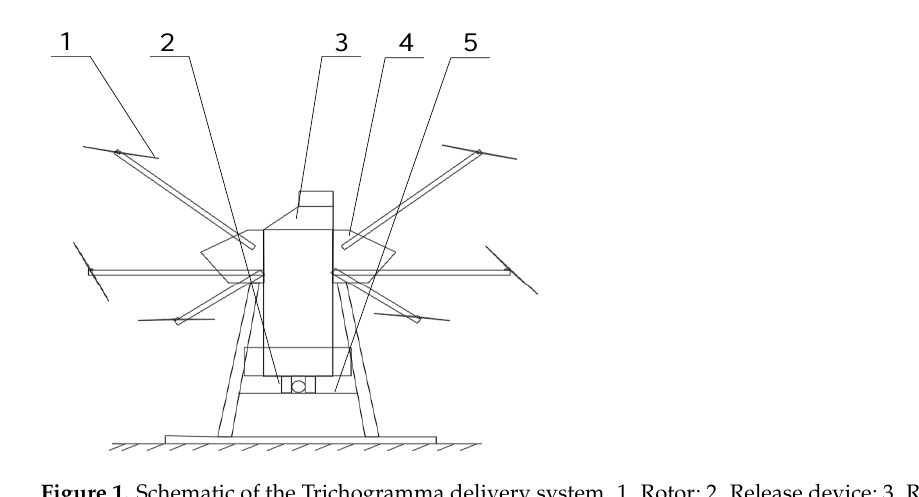
Figure 1. Schematic of the Trichogramma delivery system. 1. Rotor; 2. Release device; 3. Release box; 4. Plant protection UAV; 5. Fixed plate.